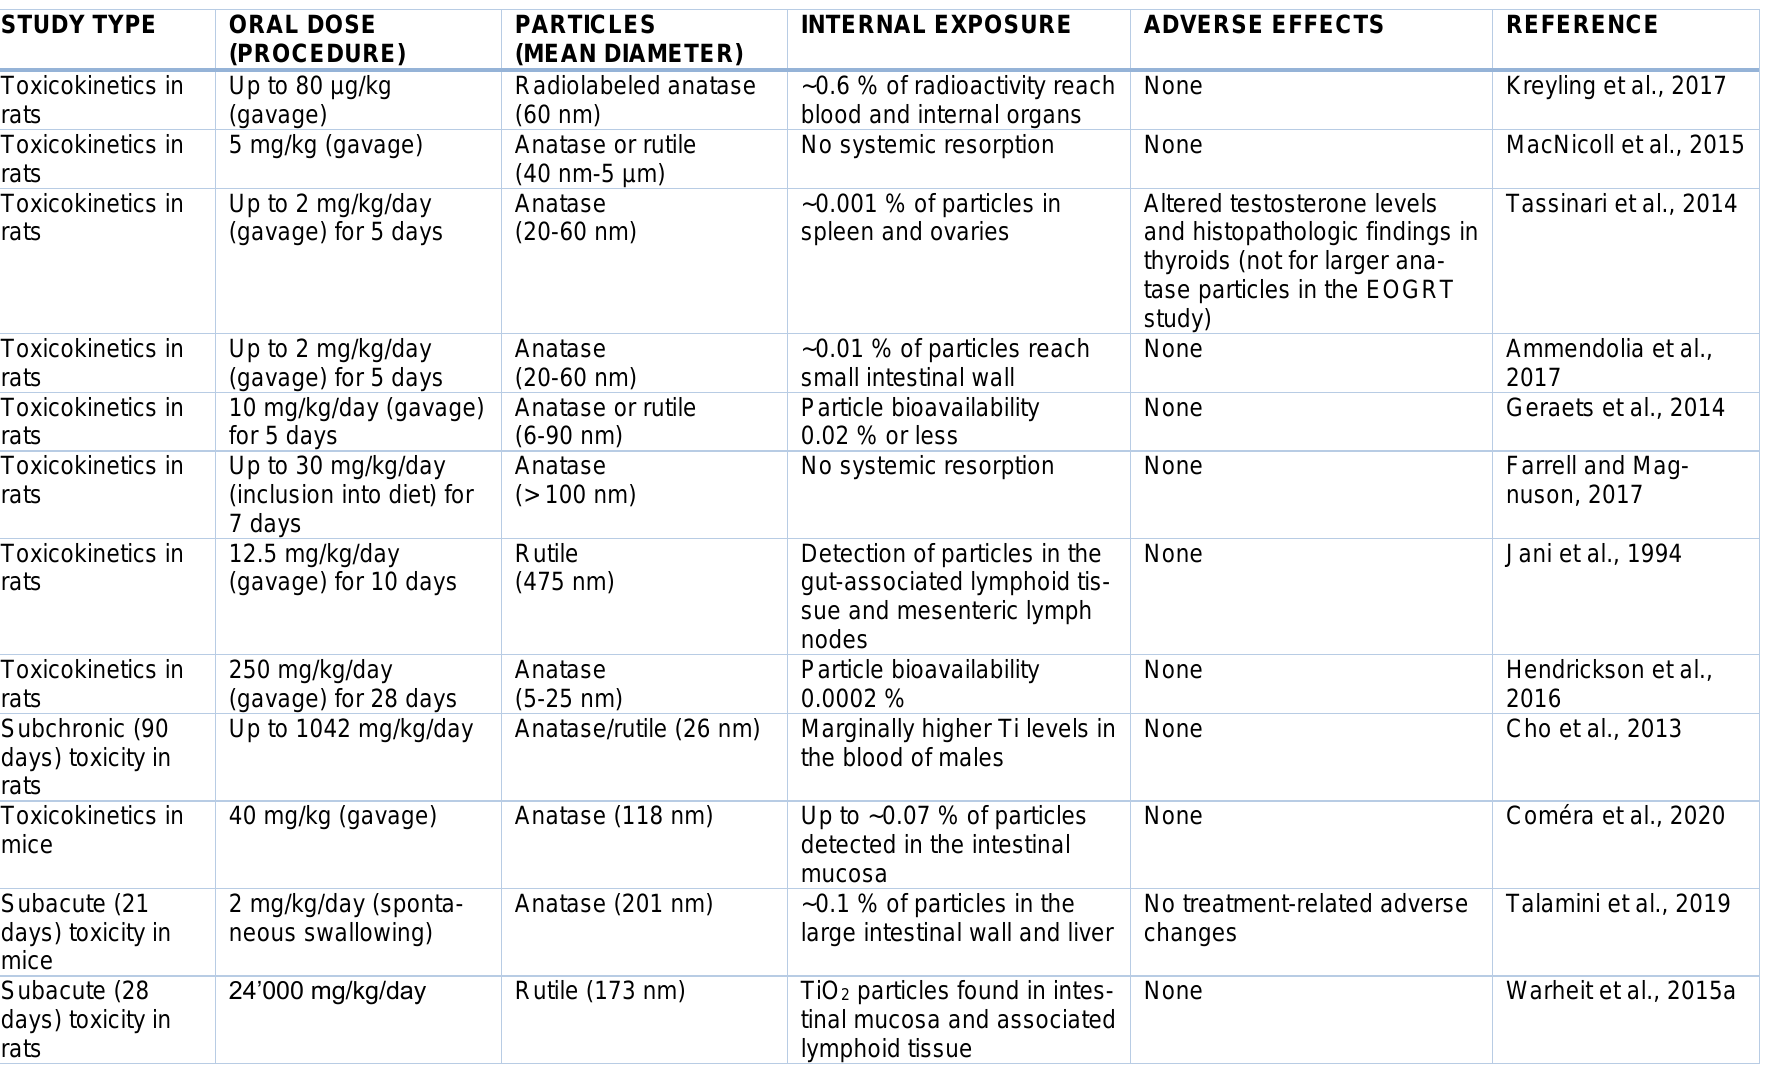
Table 2: Overview of oral toxicokinetic and toxicodynamic studies in rodents relevant for the risk assessment of